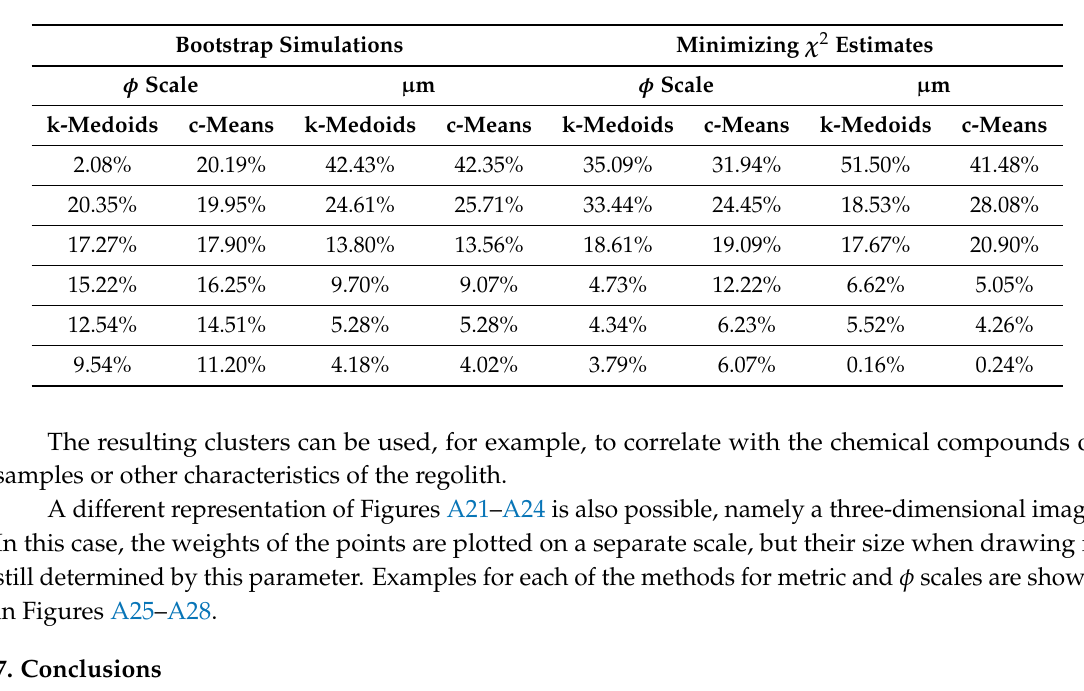
Table 1. Cluster size